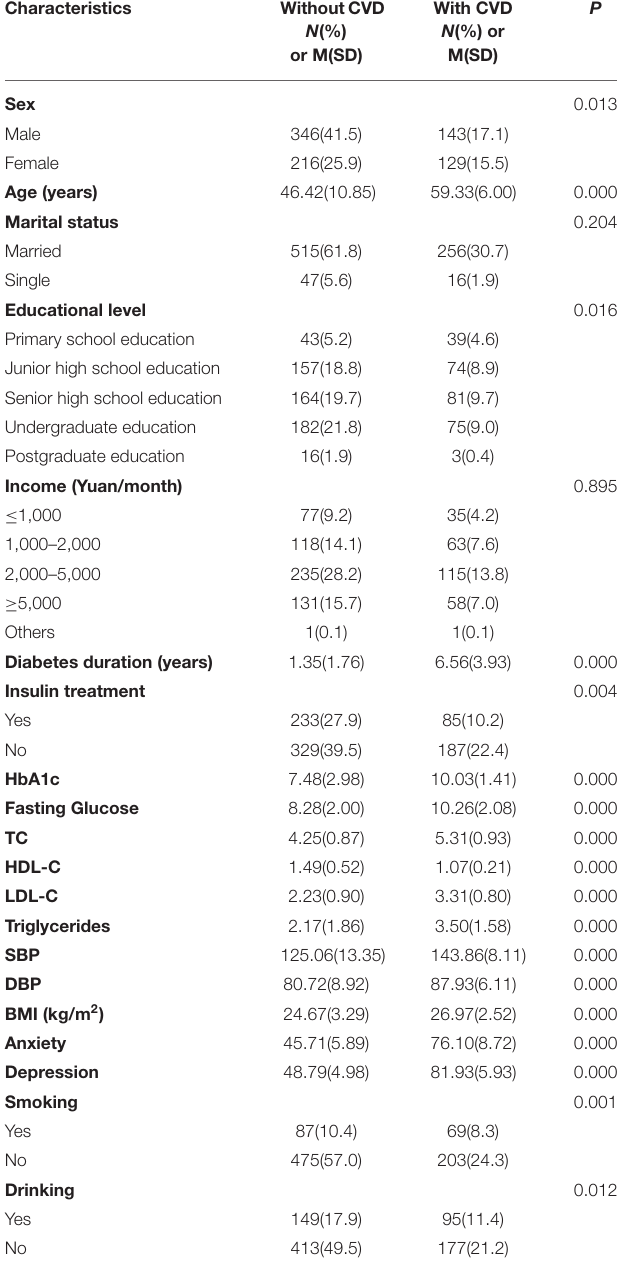
TABLE 1 | Characteristics comparison between with CVD patients and without CVD patients ( N =